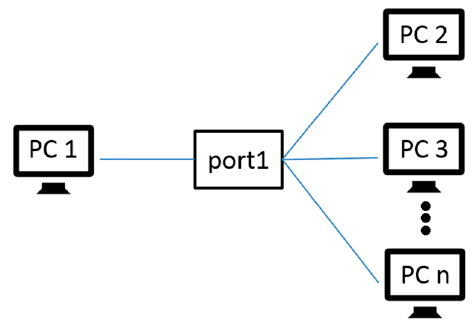
Figure 3. The diagram of the horizontal scanning schematic.